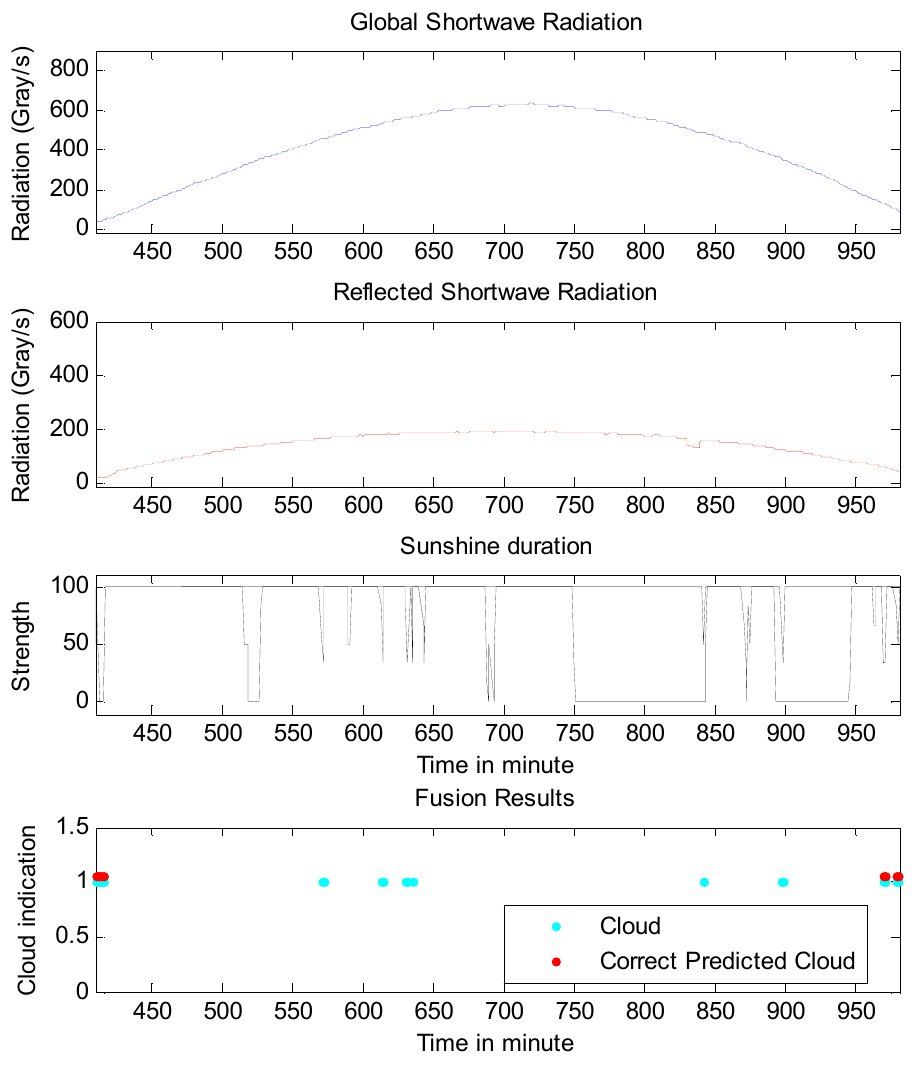
Figure 4. The comparison of the real cloud presence and the predicted cloud presence in a period, along with related sensor data on 29th of